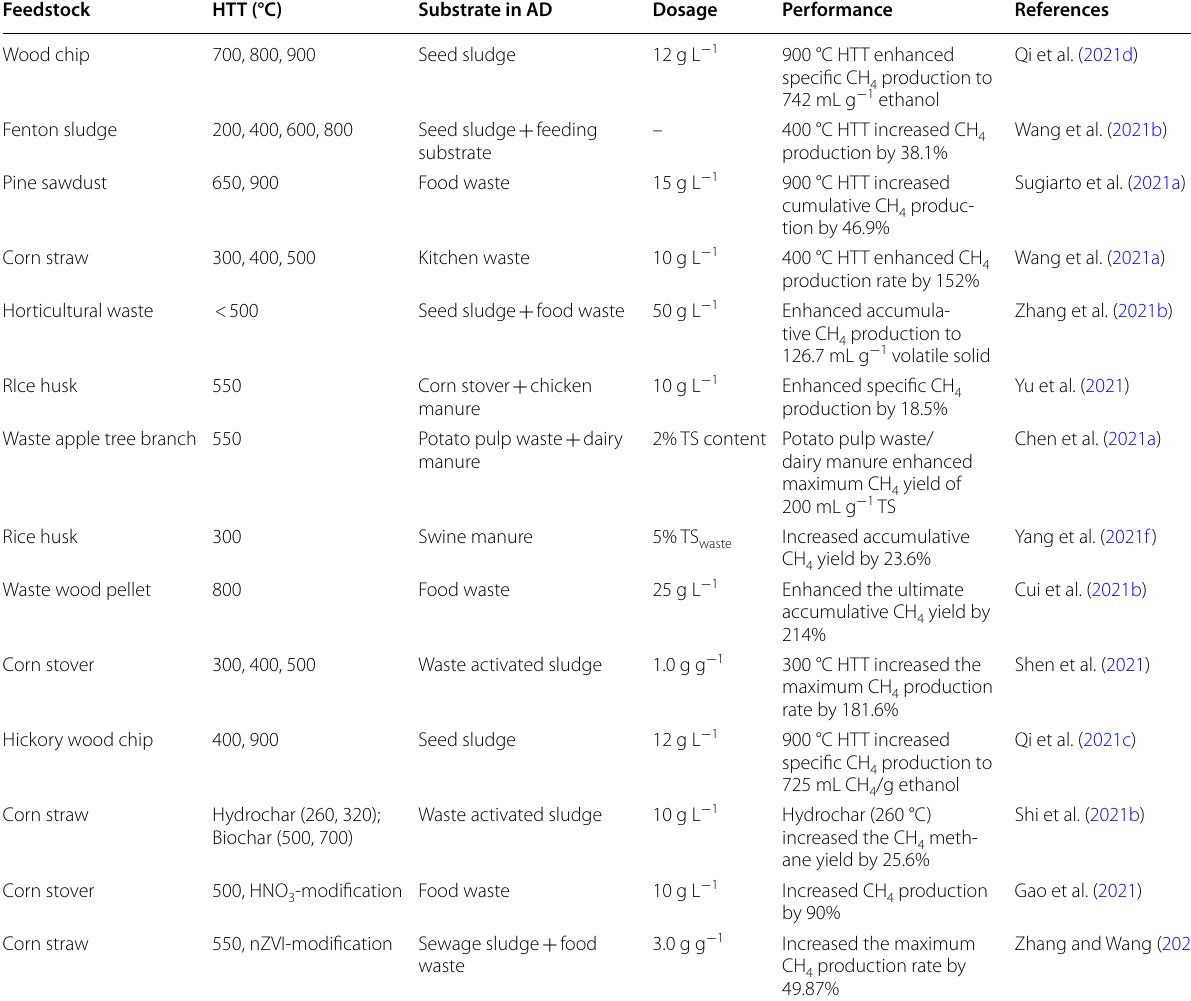
Table 2 Biochar performance in anaerobic digestion (AD) for the treatment of organic wet wastes